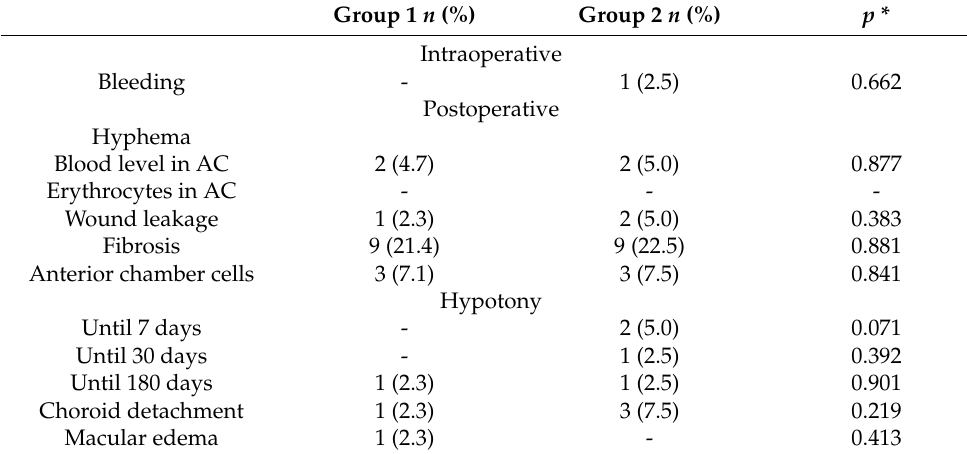
Table 4. Complications that were observed in the